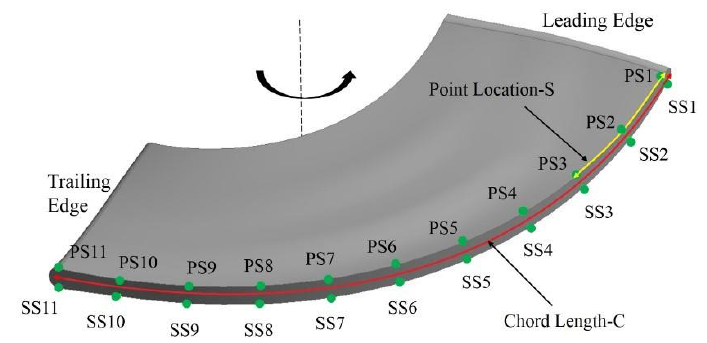
Figure 2. Monitoring points at blade tip.